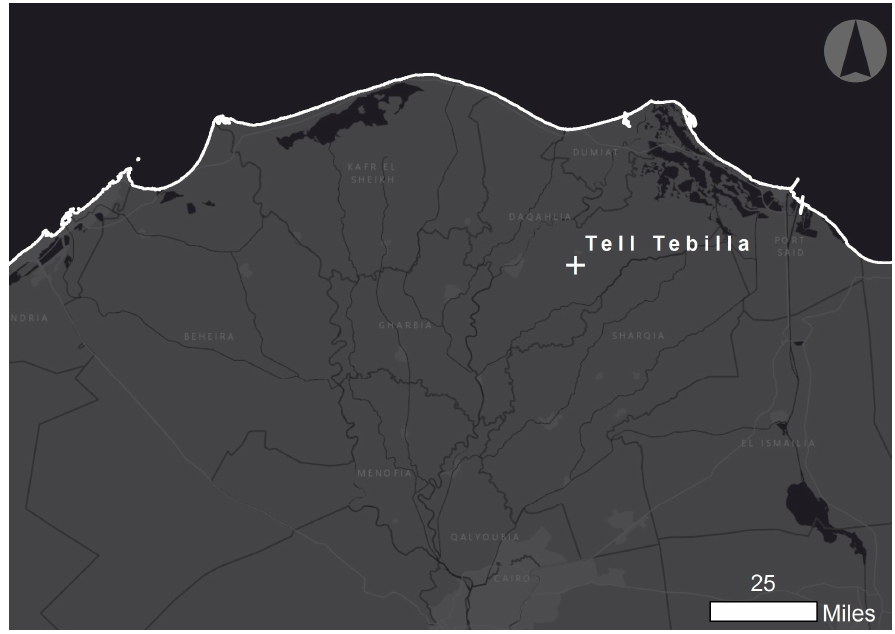
Figure 1. Location of Tell Tebilla, Eastern Delta, Egypt. Imagery courtesy Chase Childs.